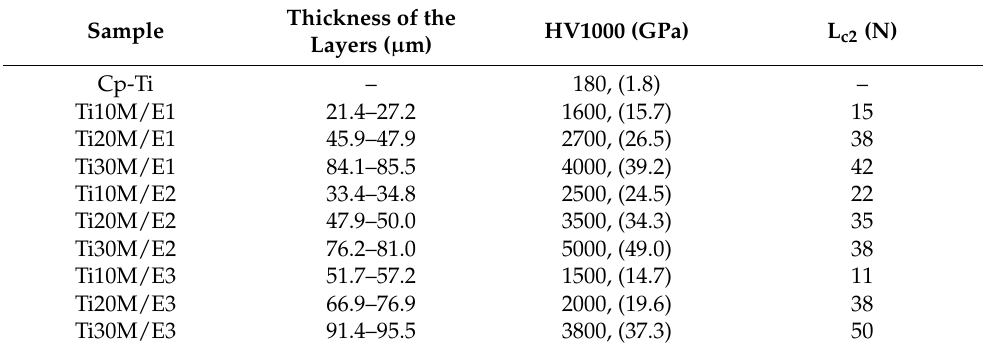
Table 2. Obtained thickness, microhardness and critical load values for the PEO layers after three sets of experiments.